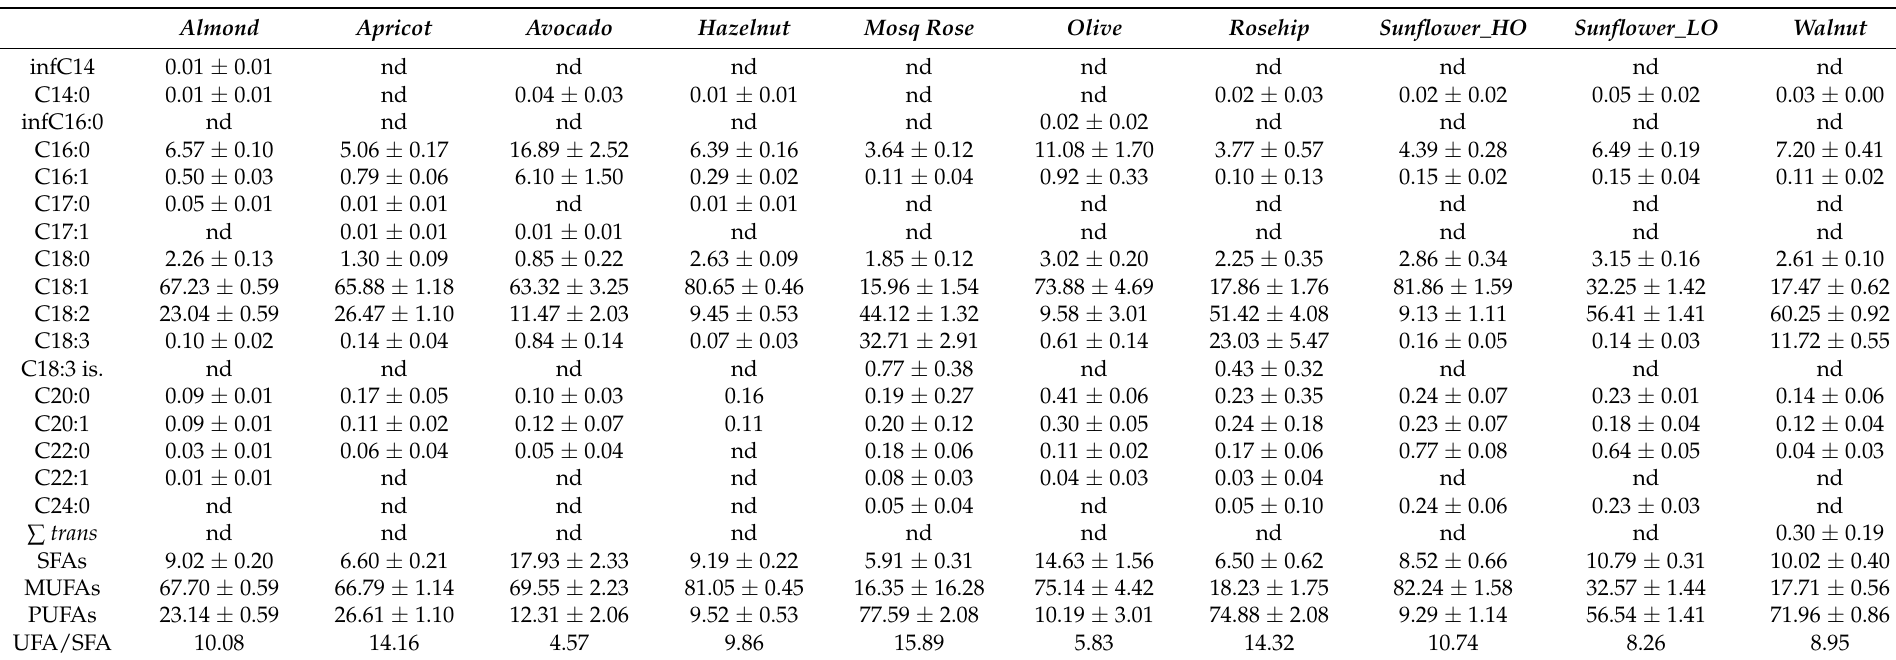
Table 2. Individual fatty acid composition, total saturated fatty acids (SFA), monounsaturated fatty acids (MUFA), polyunsaturated fatty acids (PUFA) contents and unsaturated and saturated fatty acids (UFA:SFA) ratio of analyzed gourmet oils. Results are reported as peak area percent ± uncertainty expressed as the half-width of the 95% confidence interval. Almond Apricot Avocado Hazelnut Mosq Rose Olive Rosehip Sunflower_HO Sunflower_LO